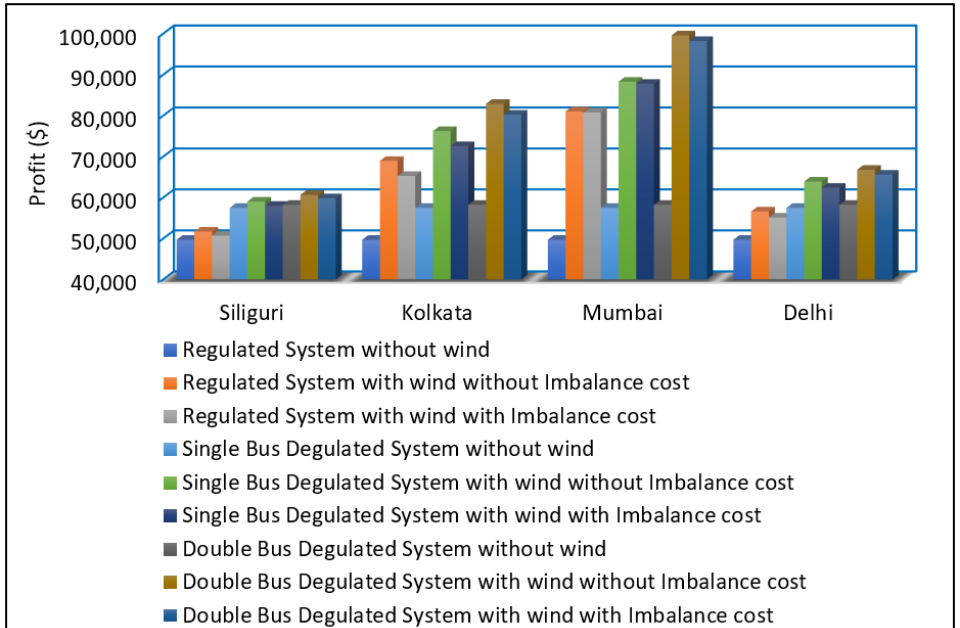
Figure 7. Comparative study of profits ($) in different locations over 24 h.